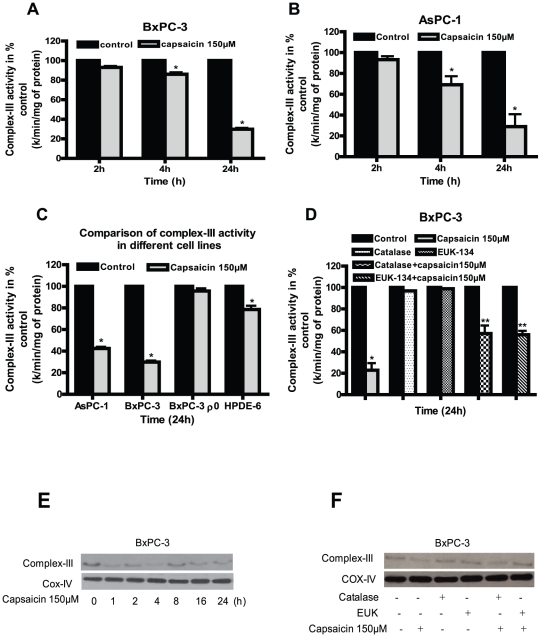
Involvement of ETC complex-III in capsaicin mediated ROS generation.Mitochondrial complex-III activity was determined in the pure mitochondria isolated from control and 150 µM capsaicin treated (A) BxPC-3 and (B) AsPC-1 cells for 2, 4 and 24 h. (C) Comparison of complex-III activity in AsPC-1, BxPC-3, BxPC-3 ρ0 and HPDE-6 cells treated with 150 µM capsaicin for 24 h. (D) Capsaicin mediated decrease of complex-III activity was attenuated by pre-treatment of BxPC-3 cells with catalase (2000 U/ml) or EUK-134 (50 µM) for 1 h followed by 150 µM capsaicin for 24 h. Results are expressed over control as mean ± SD (n = 3) of four independent experiments. *Statistically different compared with control (P<0.05) and **statistically different when compared with capsaicin treatment (P<0.05), as analyzed by one-way ANOVA followed by Bonferroni's post-hoc test. (E) complex-III protein expression was determined by immunobloting using pure mitochondrial protein isolated from control and 150 µM capsaicin treated BxPC-3 cells for indicated time periods or (F) Pretreatment with catalase (2000 u/ml) or EUK-134 (50 µM) for 1 h followed by 150 µM capsaicin for 24 h. Expression of complex-III protein was determined by immunoblotting from isolated pure mitochondria as described in the method. Each blot was stripped and reprobed with anti-Cox-IV antibody to ensure equal protein loading. These experiments were performed three times independently with similar result obtained in each experiment.